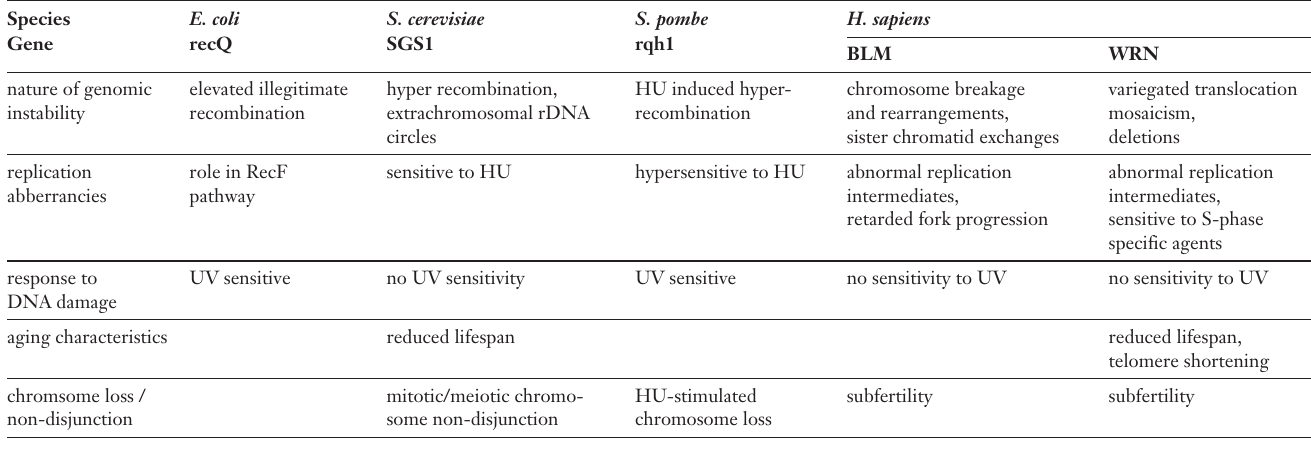
Figure 1 Schematic represen- tation of members of the RecQ family of DNA helicases from E. coli , yeast and human. The size of each protein is shown on the right. Regions correspond- ing to the helicase domains, blocks of acidic amino acids, extended homology outside the core heli- case domain, nuclear localisation signals and exonuclease domain are indicated and shown in the key below. The two sub- families are indicated by I and II at the right.